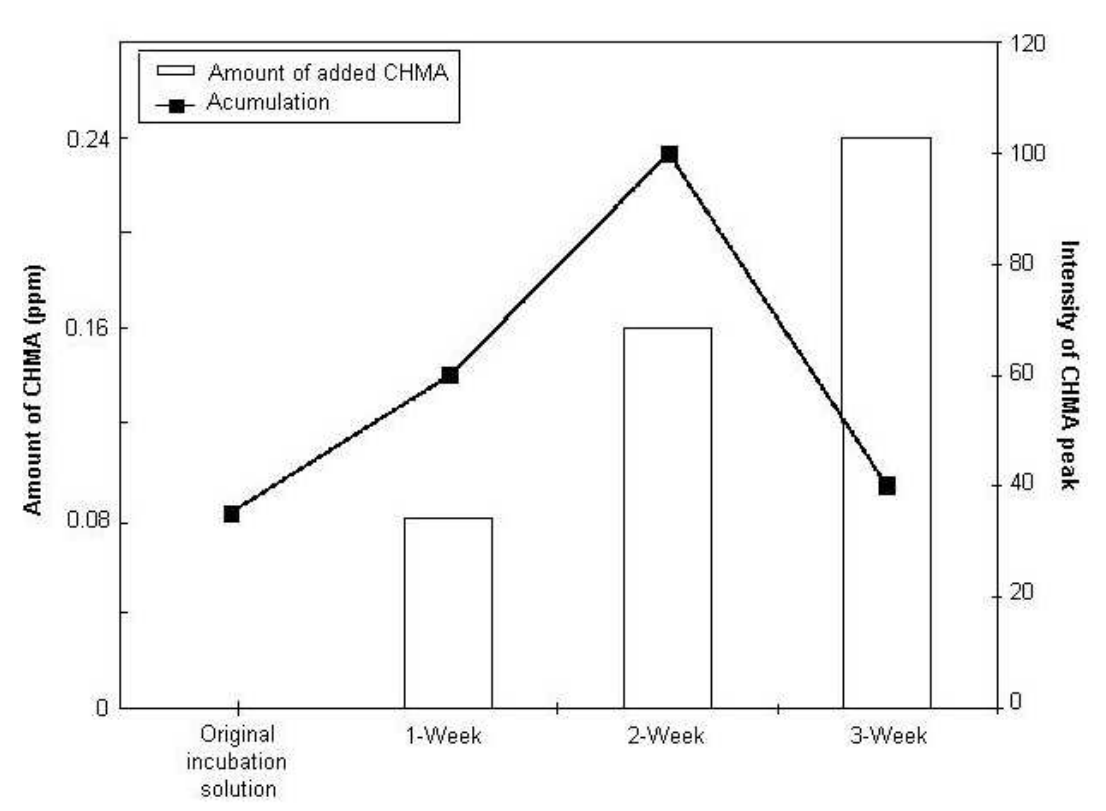
Fig. 5 Graph of MMA accumulation after different time